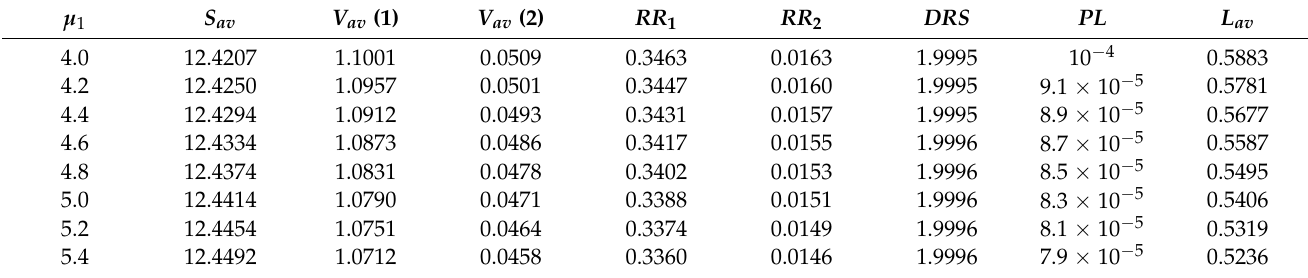
Table 2. Dependence of the performance measures on parameter µ 1 ; λ = 2, µ 2 = 6, κ = 2, τ = 2, ν 1 = 3, ν 2 = 5, r = 3, s = 8, S =